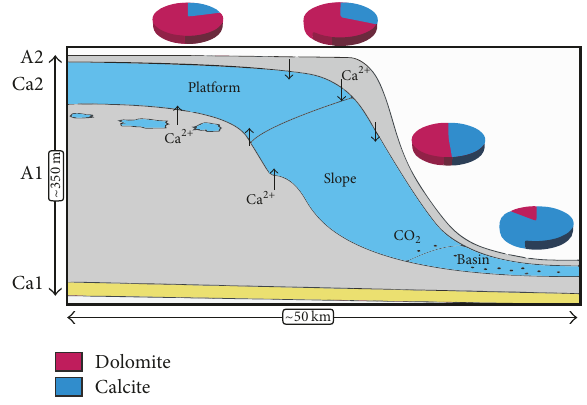
Figure 1: Dedolomitization model of the Zechstein-2-Carbonates as defined by Clark [9] (depositional model after Strohmenger et al. [1]). Dehydration of the over- and underlying gypsum deposits led to the large scale release and migration of calcium-rich fluids, as indicated by the black straight arrows. The CO 2 which is needed to bring dolomite into solution is produced during organic matter maturation which primarily took place in the lower slope to basin facies. High amounts of CO 2 lead to higher degrees of dedolomitization, explaining why basin to slope deposits show a higher degree of dedolomitization while the platform deposits are largelydolomitic.Piechartsdisplayingthedistributionofcalciteand dolomite for different depositional environments are chosen from representative wells within the study